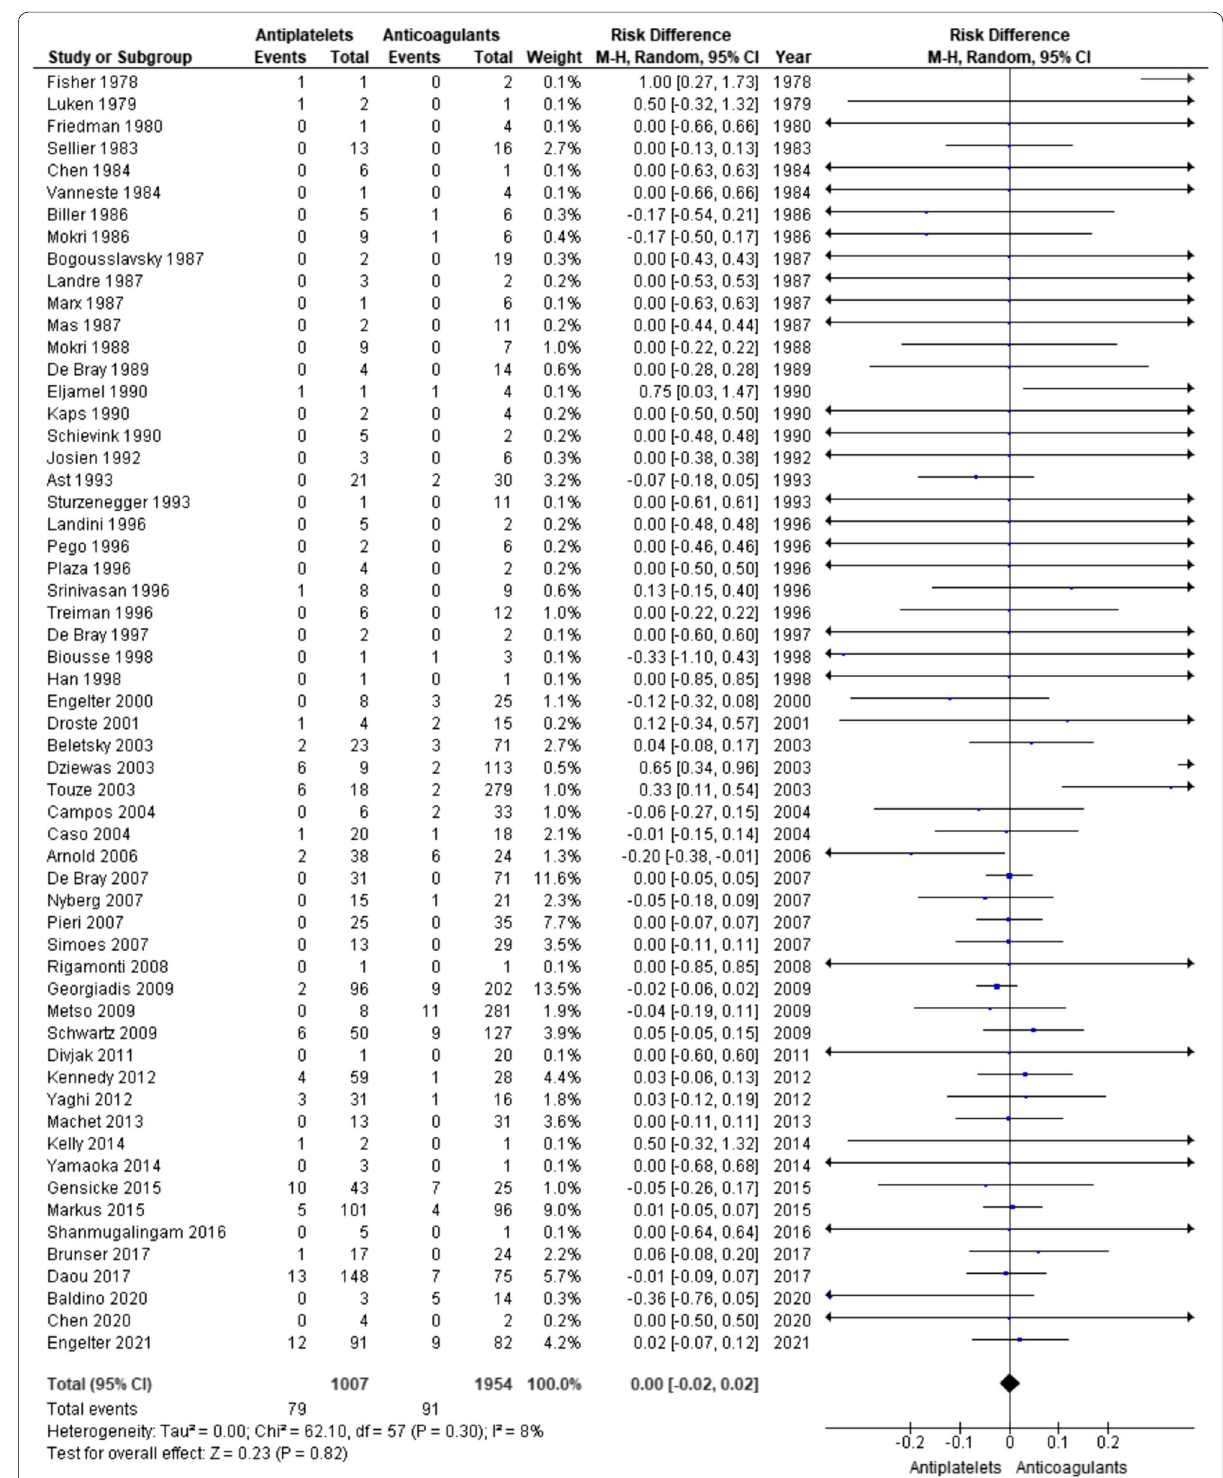
Fig. 3 Forest plot for ischaemic stroke or TIA